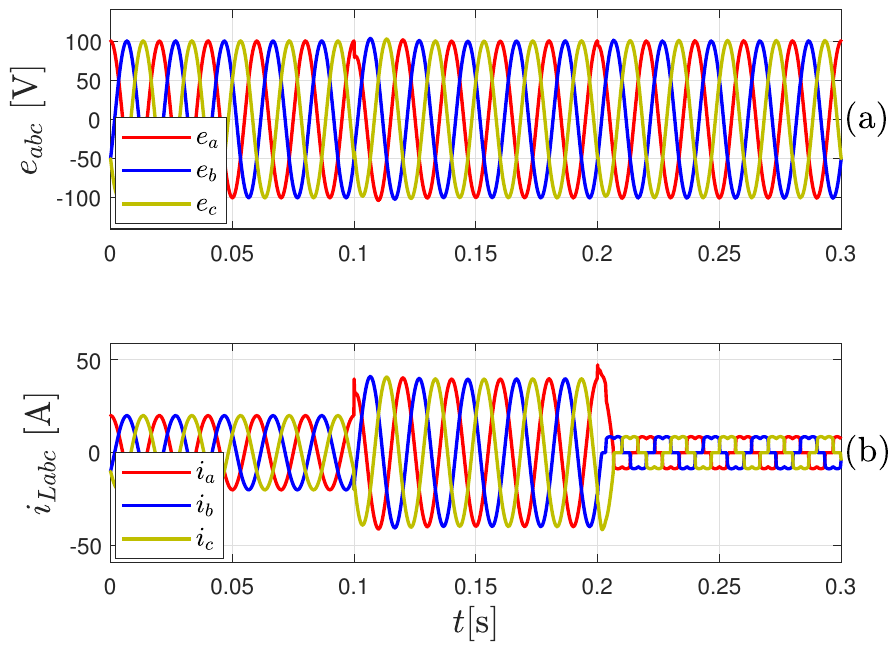
Figure 5. Dynamical performance of the voltage and currents at the point of load connection. ( a ) Three-phase voltage profile. ( b ) Current profile for linear and nonlinear